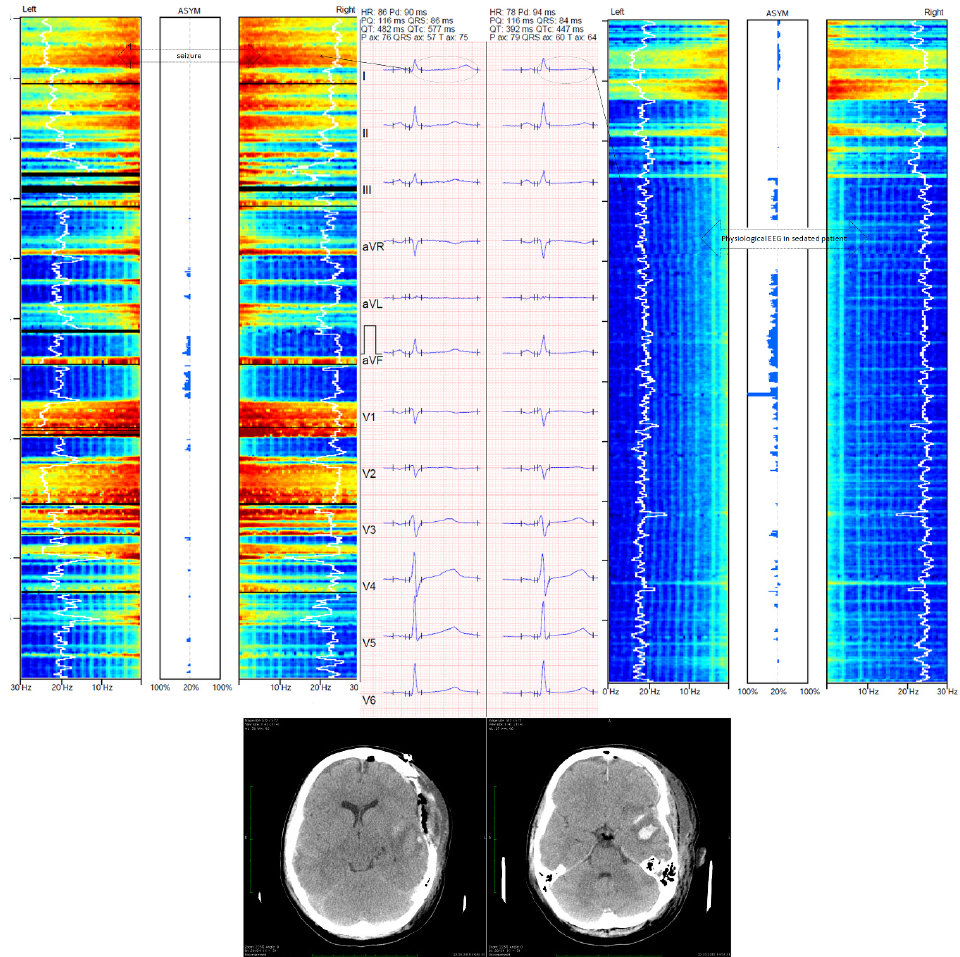
Figure 1. Changes in frontopolar electroencephalography monitored with Medtronic BIS ™ device and corrected QT (QTc) interval. The left part of the figure presents an electrographic seizure and ECG with prolonged QTc (577 ms, calculated with Bazett’s formula). The right part of the figure presents ESz suppression following thiopental administration with reduction in the QTc interval (447 ms, calculated with Bazett’s formula). The case shown is a 22 year-old woman who was admitted to the intensive care unit (ICU) for severe TBI. Her Glasgow Coma Score was 6. Computed tomography (CT) showed acute epidural hematoma with intracerebral hemorrhage. Immediately after CT, craniectomy was performed. According to the local ICU protocol, frontopolar electroencephalography (EEG) was used. Controlled CT was performed 24 h after surgery and showed slight cerebral edema with cerebral lesion and intracerebral hematoma in the temporal region. Despite depth sedation (BIS ranged between 10 and 20), EEG showed alternate polyspike and slow wave without clinical symptoms 24 h after the admission to the ICU. The ESz recurred for 2 h. Hence, status epilepticus was diagnosed and continuous thiopental infusion at the dose of 50 µg.kg − 1 .min − 1 was used to suppress ESz. Such disorders were not observed during treatment in the ICU. Patient was discharged from the ICU 32 days after trauma.